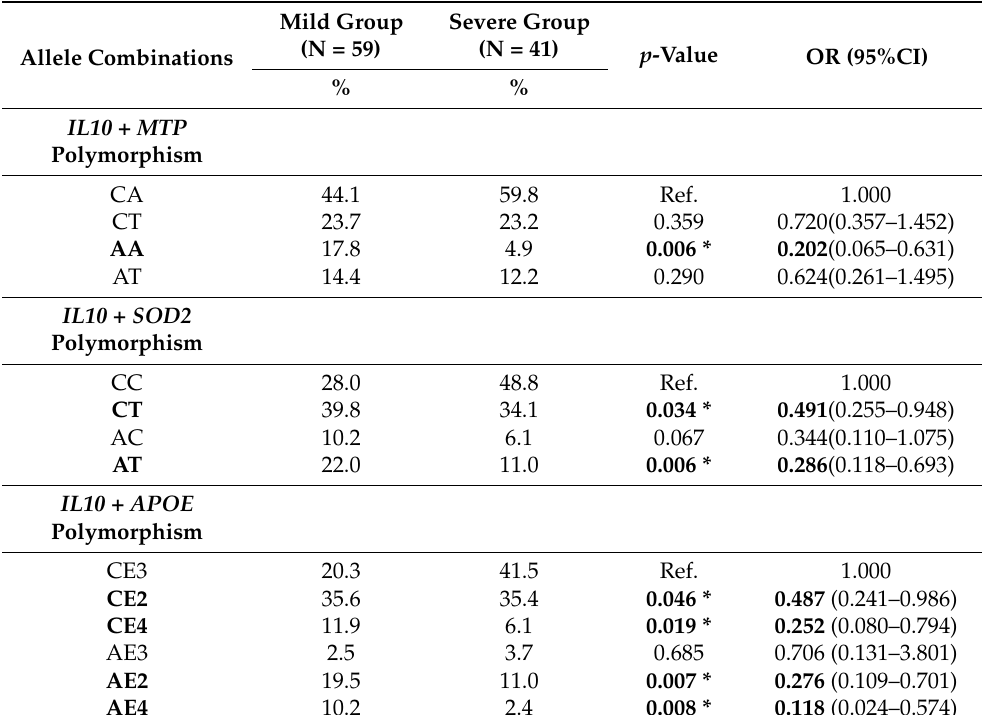
Table 4. Analysis of two-gene combination alternately for alleles of IL-10 -627 (C/A), MTP -400 (A/T), SOD2 1183 (C/T), and ApoE (E3, E2, and E4) in the Mild and Severe fibrosis groups.